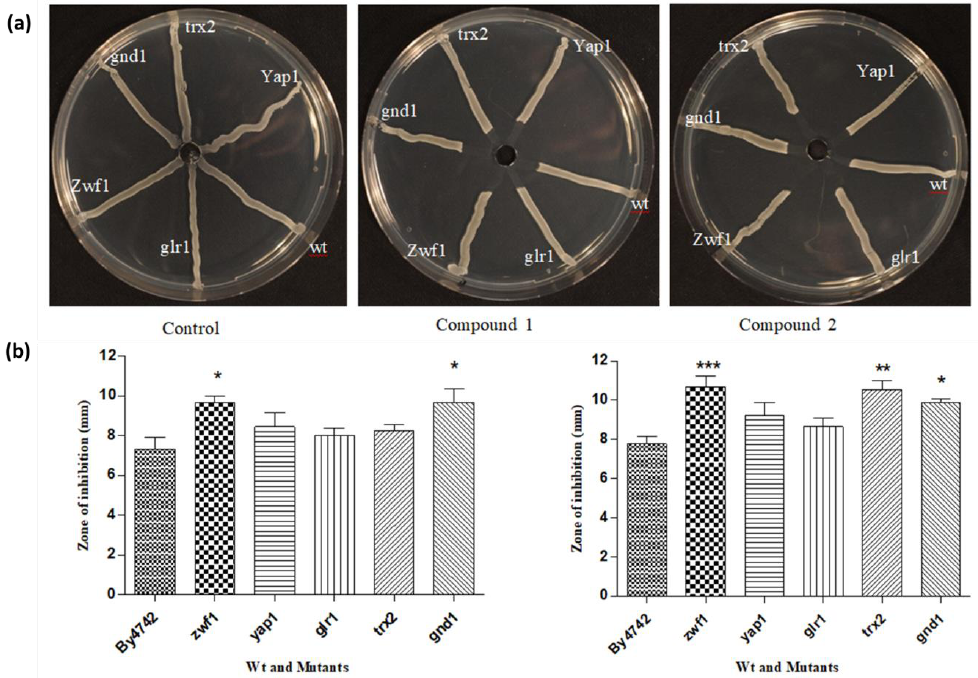
Figure 7. The streak test technique for comparing the inhibition of wt and different mutants by the compounds. This assay does not give such a clear result as the plate inhibition zone test (Figure 5), however wt and several mutants can be tested on a single Petri plate. (a) In the example shown, 20 μL of 1 mM of test compound was pipetted into the central well. (b) Graphs showing the zones of inhibition of wt and mutants treated with compound 1 (Graph on the left side) and compound 2 (Graph on the right side) Values represent mean ± S.D. * p < 0.05, ** p < 0.01 and *** p < 0.001. The growth inhibition zone of mutants was compared with that of wt after treatment with selenocyanates.